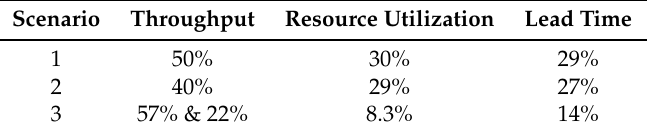
Table 5. Improvements of the adaptive approach relative to the Spark